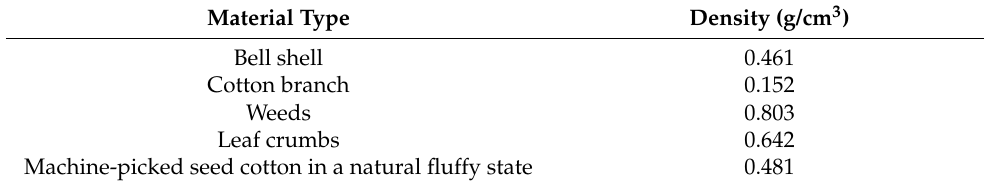
Table 3. Density of each substance in machine-picked seed cotton.